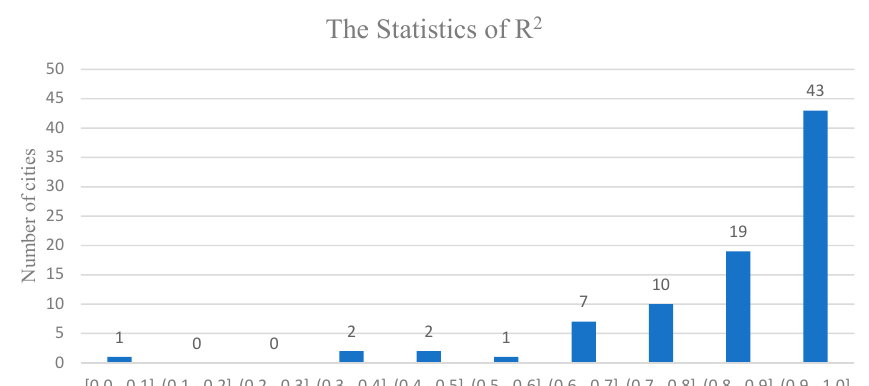
Figure 3. Statistics of R 2 calculated by the OSM road network density.